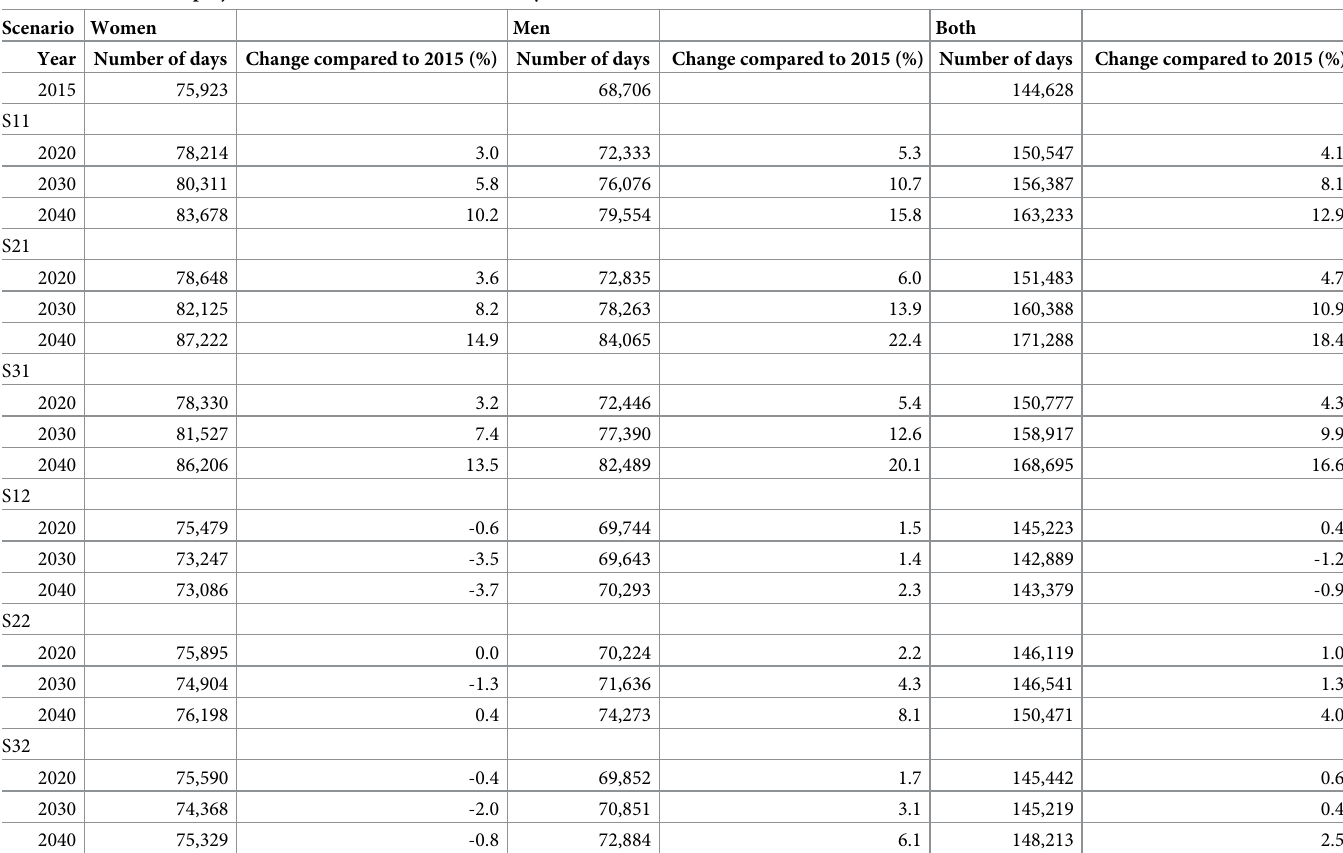
Fig 4. Projection of the number of treatment days until 2040 (in 1,000). (A) women (B) men. Source: Hospital statistics 2000–2015 [19], population statistics [20] own calculations.